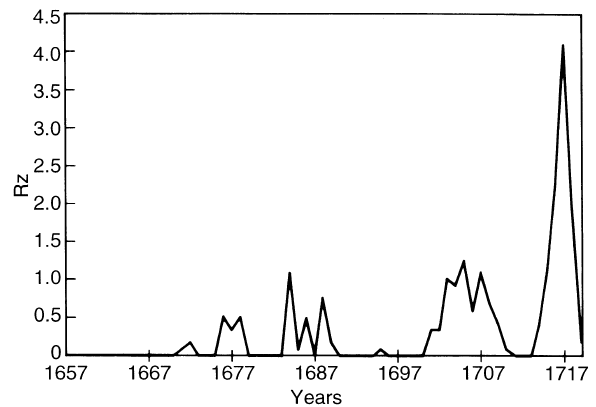
Fig. 1. Annual sunspot number during the Maunder minimum, 1645– 1715, after Ribes and